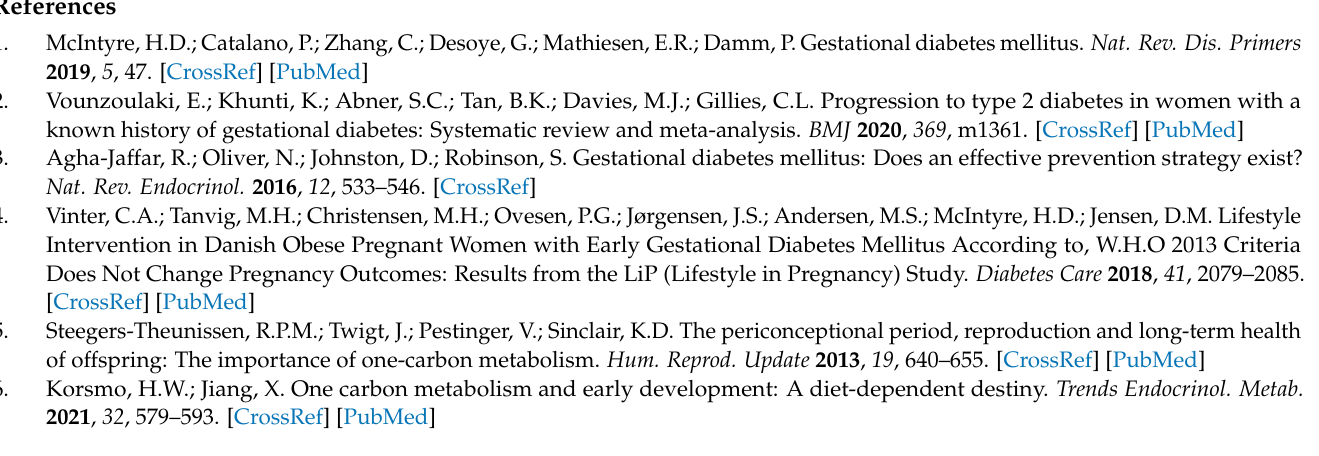
morphisms; Figure S1: Spearman’s correlation matrix of serum OCM indicators, and fasting, 1-h, and 2-h plasma glucose; Figure S2: Restricted cubic spline (RCS) regression analysis of OCM indicators with GDM risk; Figure S3: The associations between OCM related SNPs and GDM under three different genetic models: dominant, recessive, and